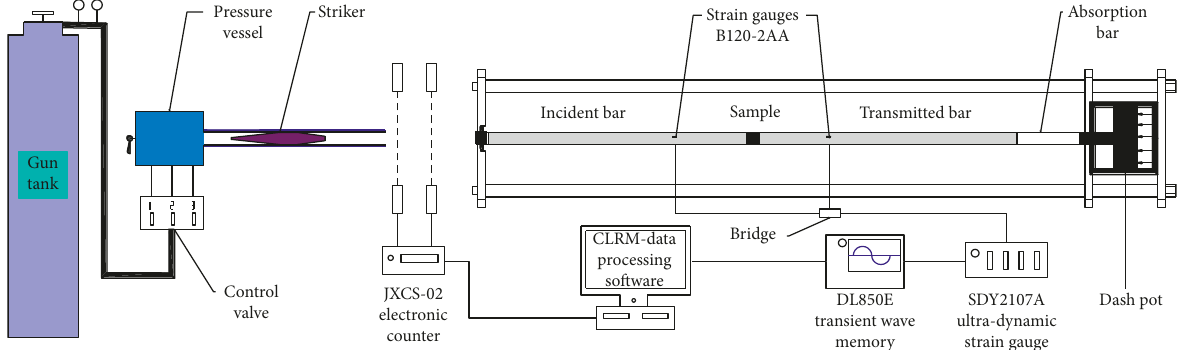
Figure 2: The SHPB test